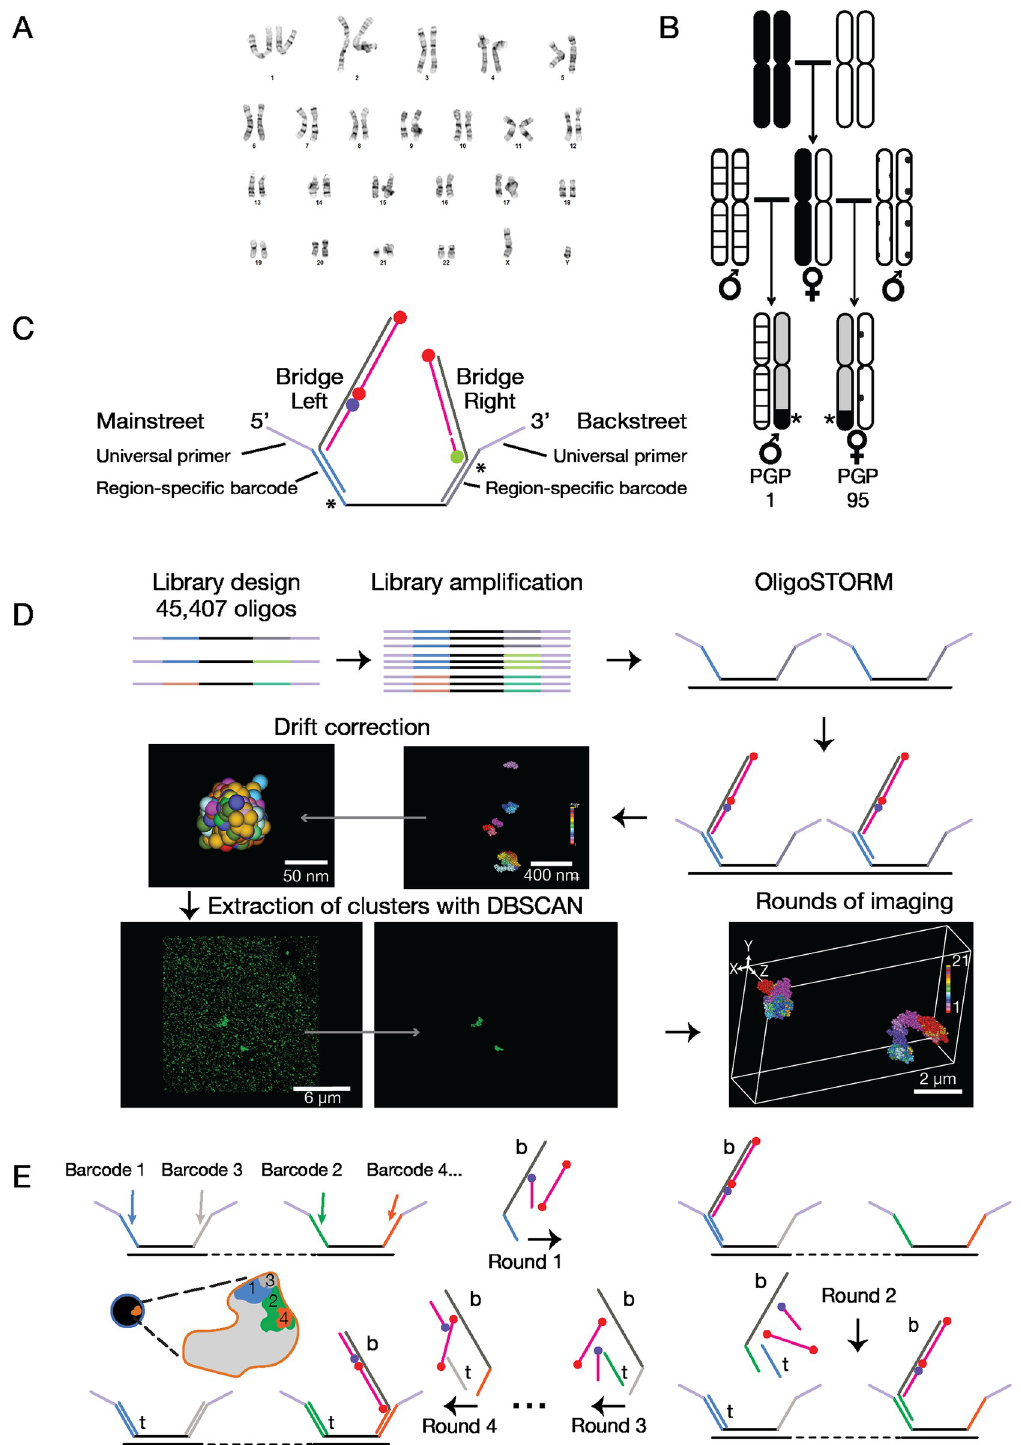
Fig 1. Tools. ( A ) PGP1f karyotype (Methods). ( B ) Assignment of parental origin to homologs of chromosome 19 through pedigree analysis. Black and white, homologs of chromosome 19 in maternal parent of PGP1 and PGP95; patterned, homologs of paternal parents; asterisk and black, large SNV block shared between PGP1 and PGP95 identifying maternal homolog; grey, maternally derived regions without large SNV blocks shared by PGP1 and PGP95. ( C ) Oligopaint oligos (129–135 nts) consist of a segment of genomic homology (black; 35–41 nts) flanked by Mainstreet and Backstreet (47 nts), each consisting